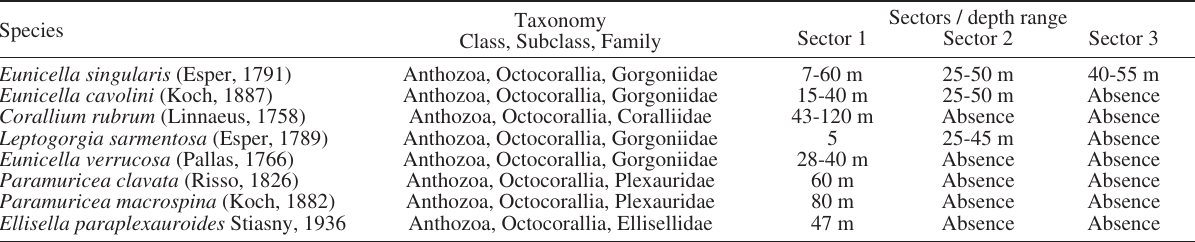
Table 2. – Gorgonian species, taxonomy and distribution (sector and depth range) in Tunisian waters. Taxonomy Species Class, Subclass,